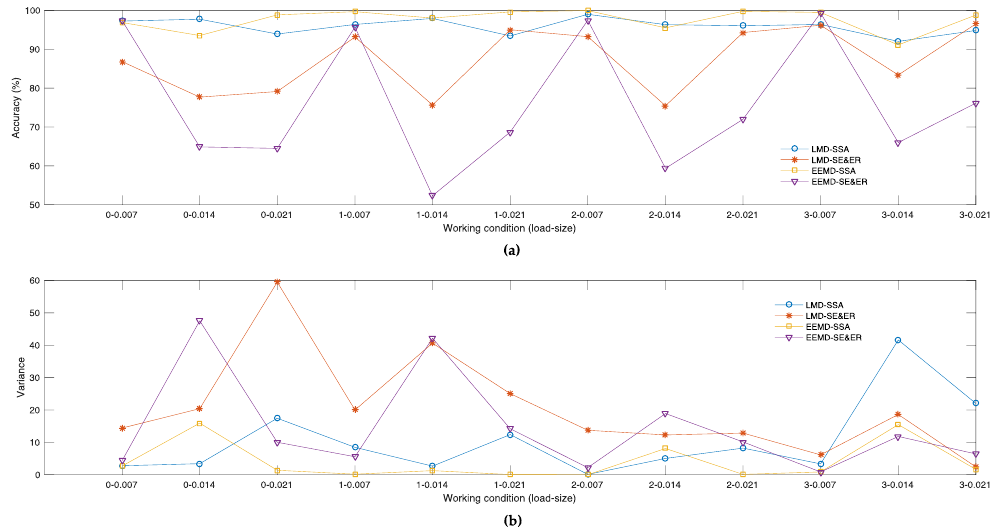
Figure 6. ( a ) Average diagnostic accuracy to all independent experiments corresponding to 12 different working conditions respectively with the scheme of (5/95) in the 1st–4th experimental sets. ( b ) Variance of diagnostic accuracy to all independent experiments corresponding to 12 different working conditions, respectively, with the scheme of (5/95) in the 1st–4th experimental sets.